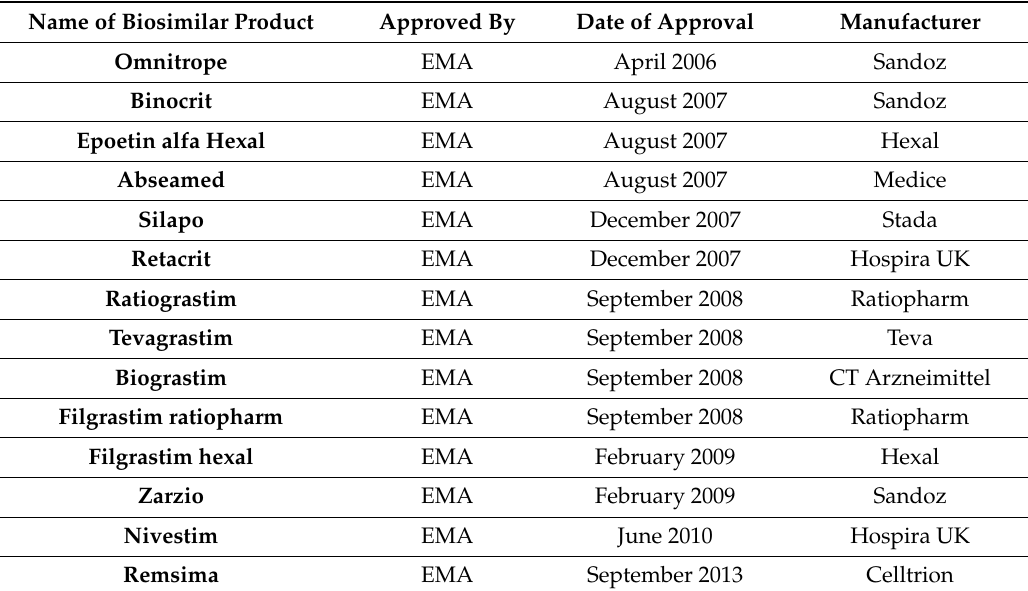
Table A1. List of Biosimilars approved till